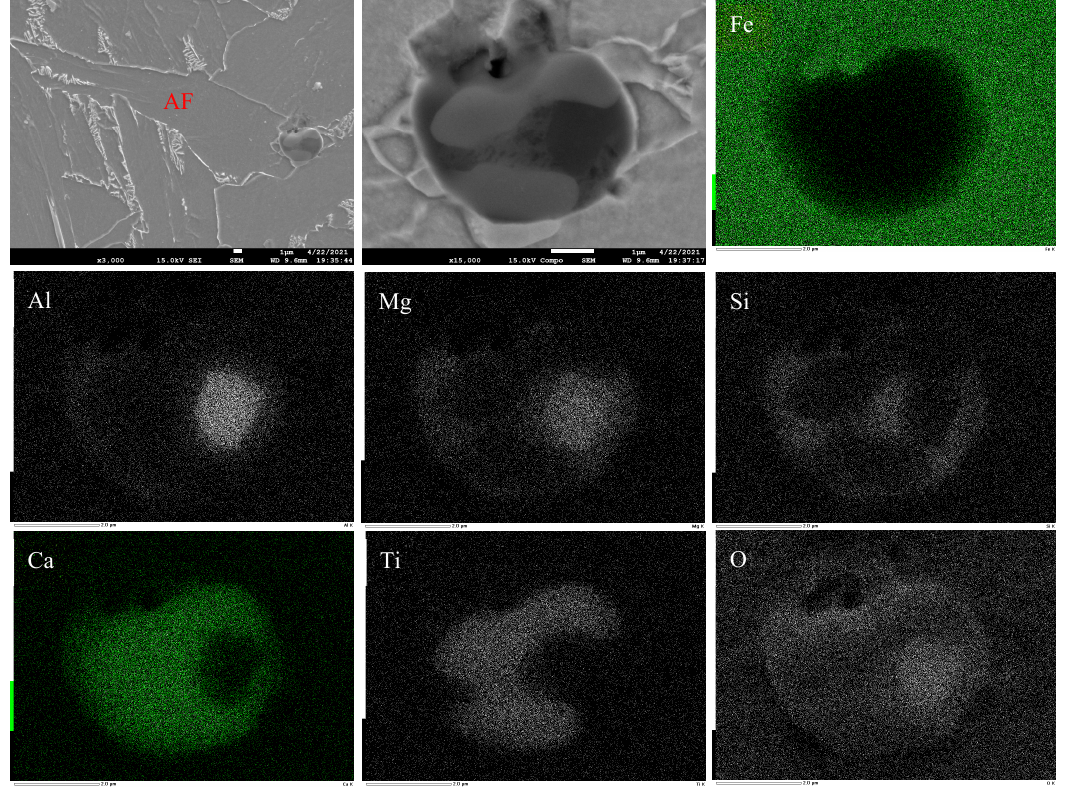
Figure 17. EDS mapping analysis of one typical inclusion A effective for IAF nucleation in Ti-Ca deoxidized steel.